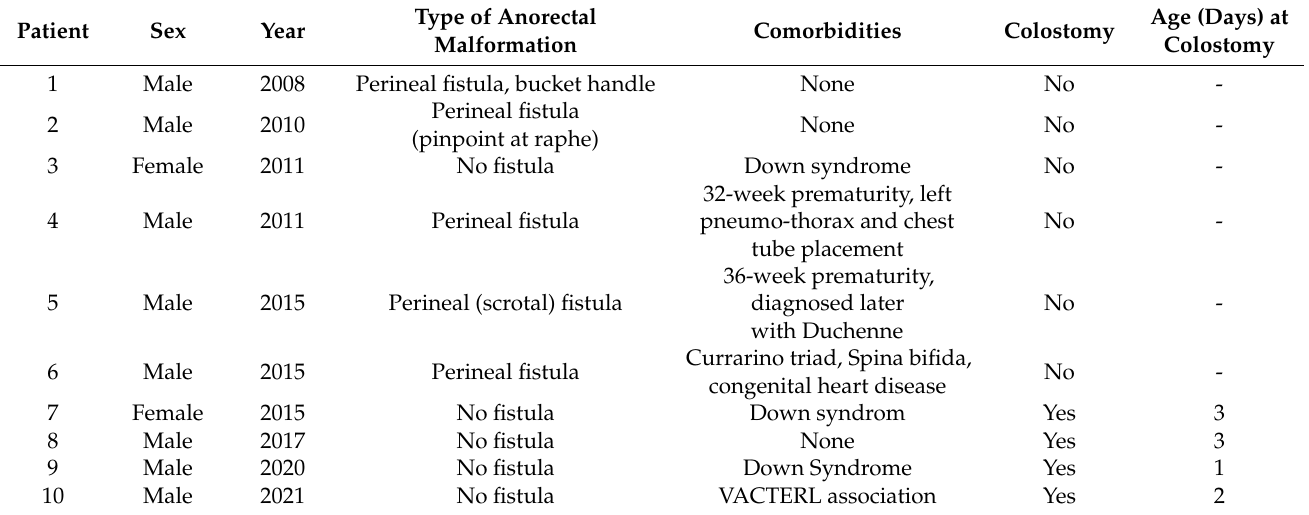
Patient demographics and data (VACTERL—vertebral, anorectal, cardiac, tracheo- esophageal, renal, limb